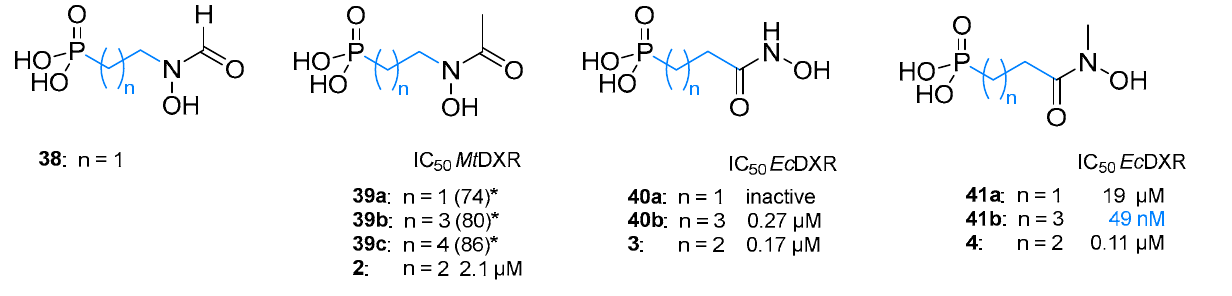
Figure 13. Biological activities of analogs 38 – 41. Values marked with * indicate the percentage of inhibition at 100 µM.